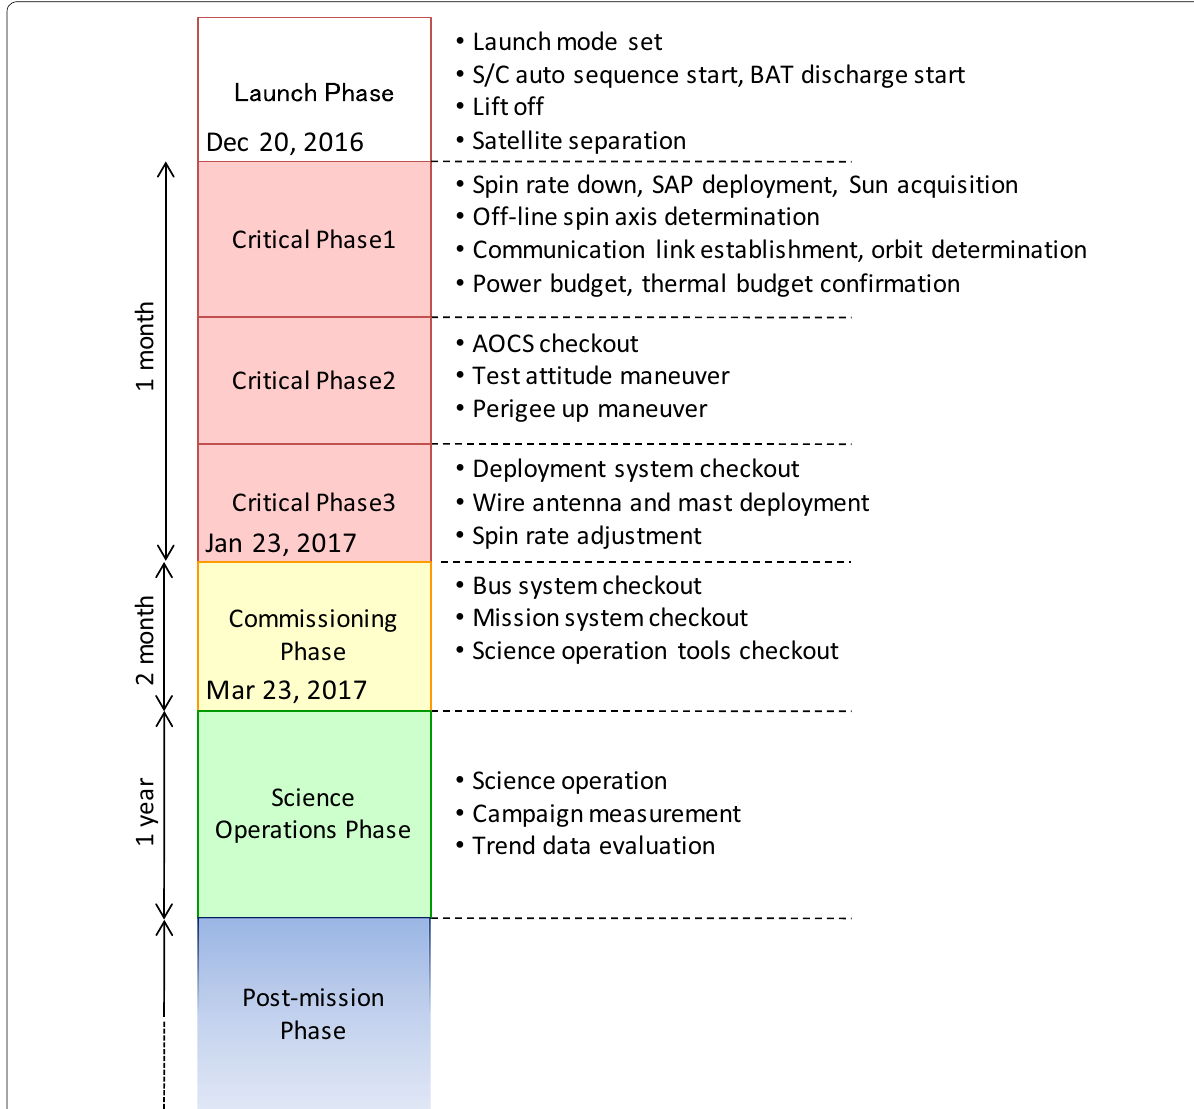
Fig. 12 Operation phase of the ERG